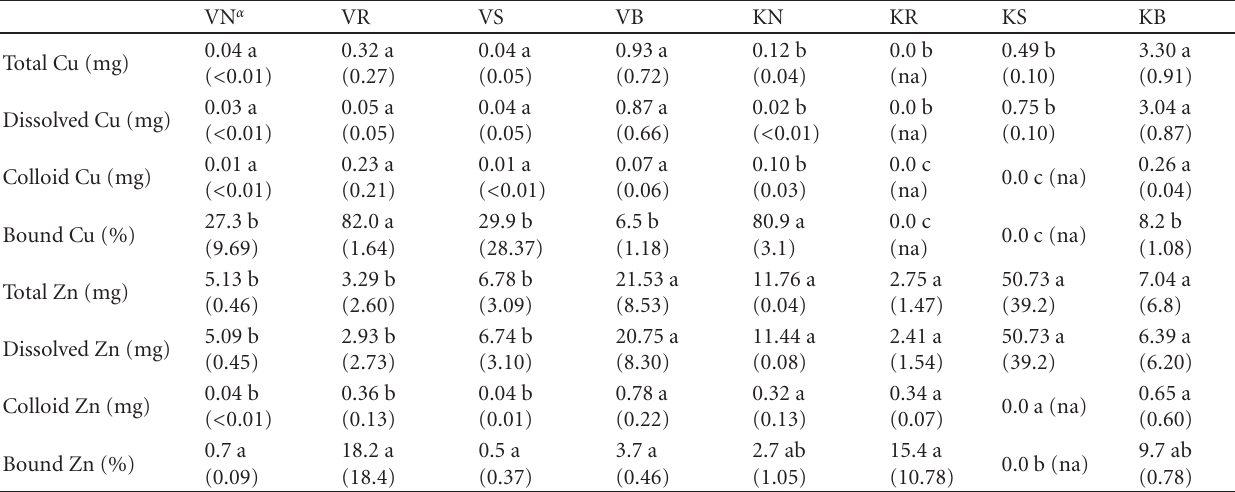
Table 3: Total, colloidal, and percent-bound Cu and Zn for eluents from the Virginia and Kentucky treatments ∗